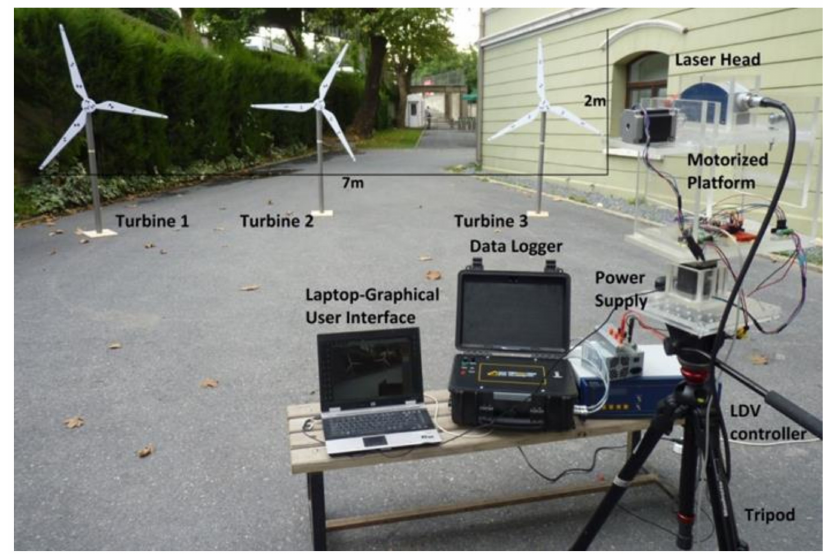
Figure 4. Outdoor tests performed to validate the scanning efficiency